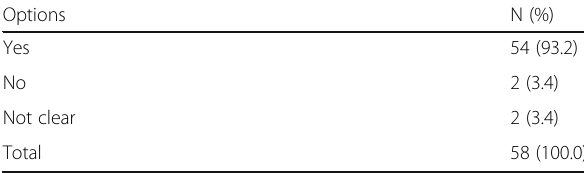
Table 2 willingness of participation in BRI Health